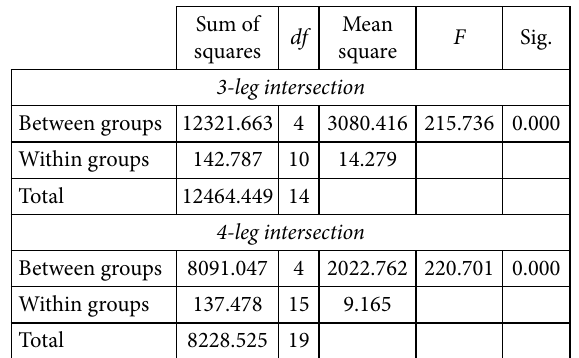
Table 8. ANOVA per vehicle type